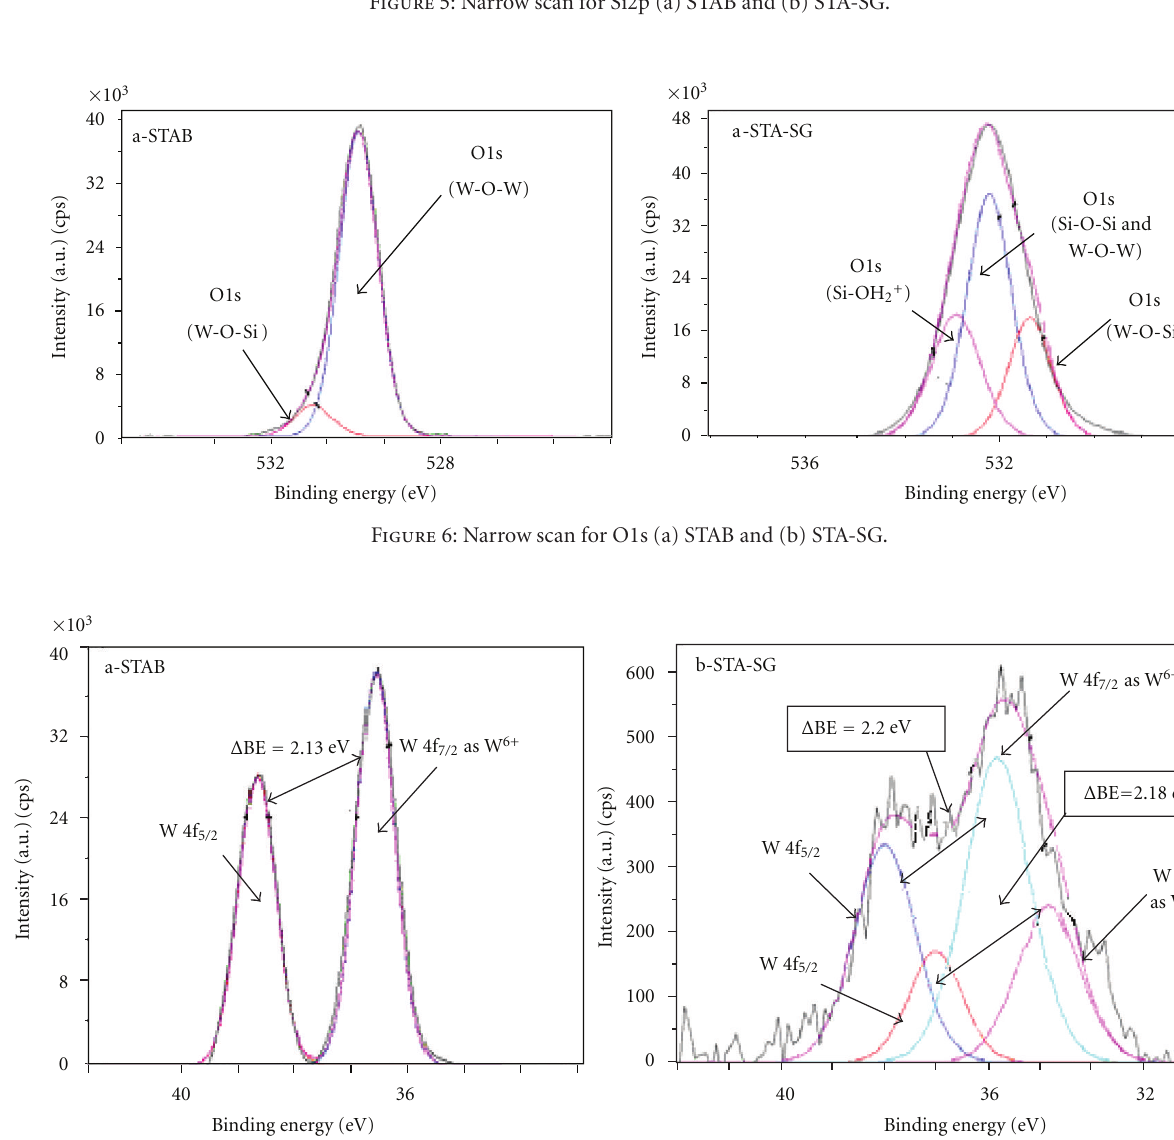
Figure 7: Narrow scan for W4f (a) STAB and (b)